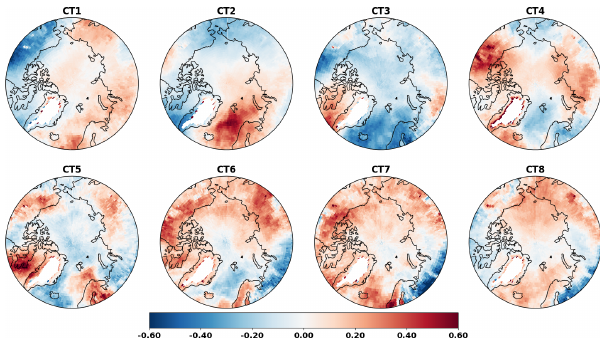
Figure 3. The 850hPa specific humidity anomalies (g kg − 1 ) based on AIRS data for the eight circulation